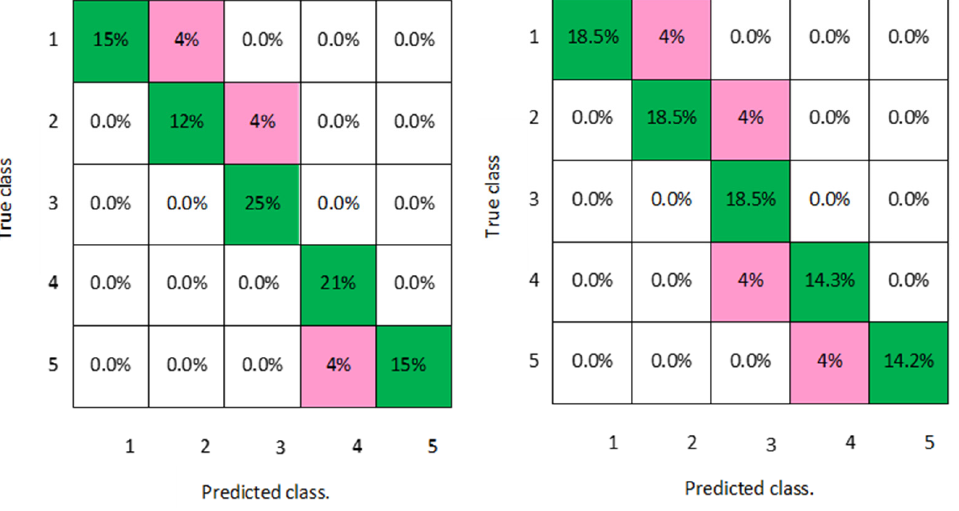
Figure 4. Quadratic SVM model confusion matrixes for men and women data, respectively.